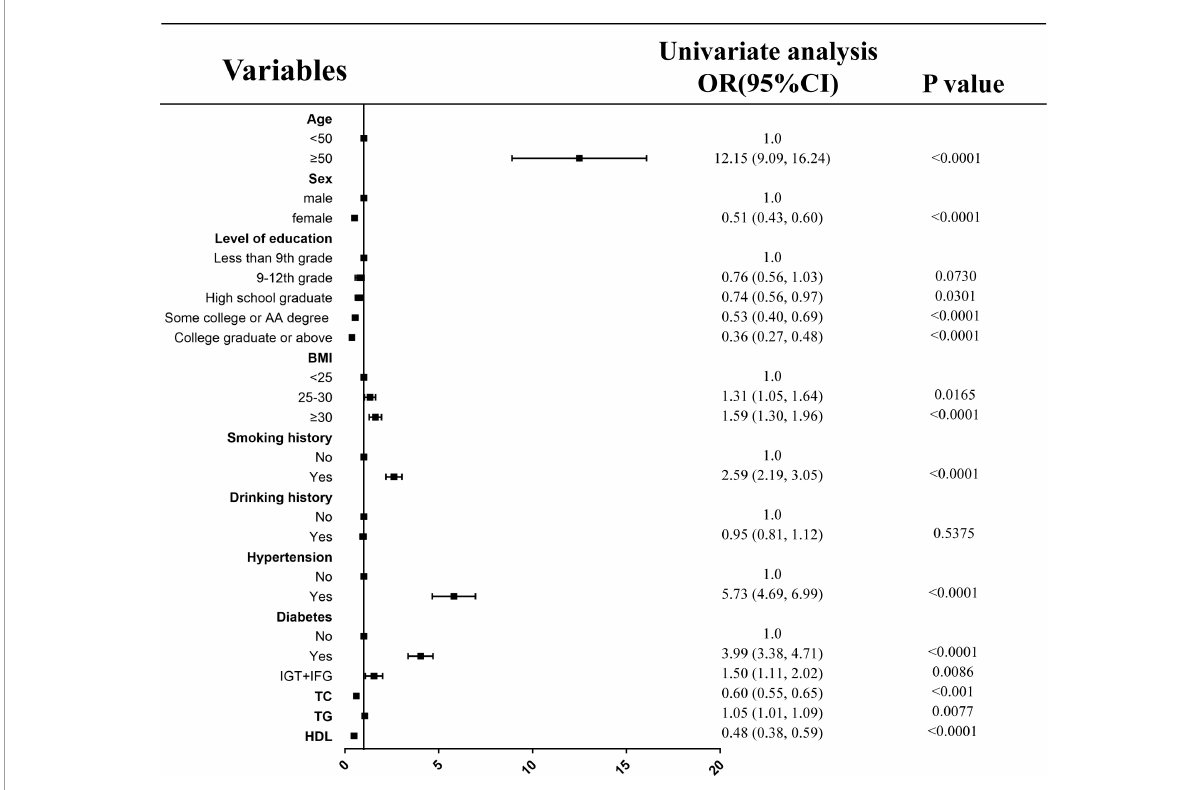
FIGURE1 Effects of various factors on myocardial infarction by univariate